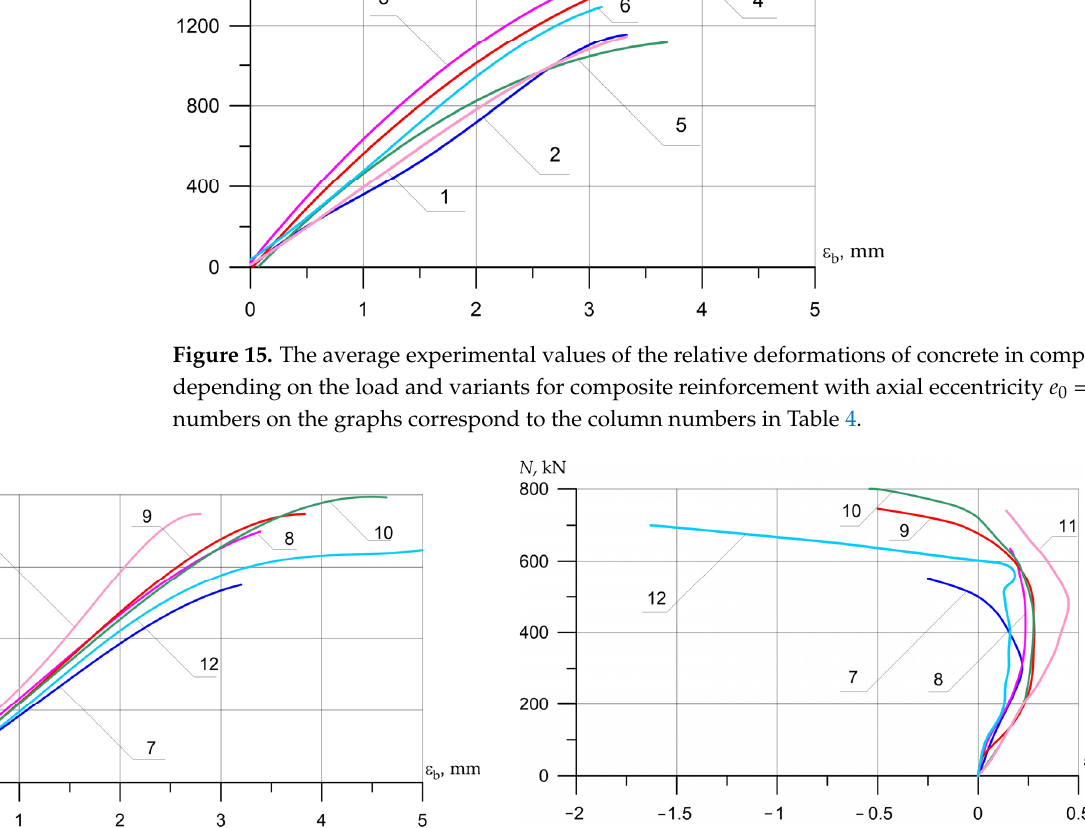
Figure 16. Comparison of the average experimental values of the relative deformations of concrete in compression ( a ) ε b and tension ( b ) ε bt on opposite faces of the columns ( λ h = 10) depending on the load and variants for composite reinforcement with axial eccentricity e 0 = 2.0 cm (0.16 h). The numbers on the graphs correspond to the column numbers in Table 4.